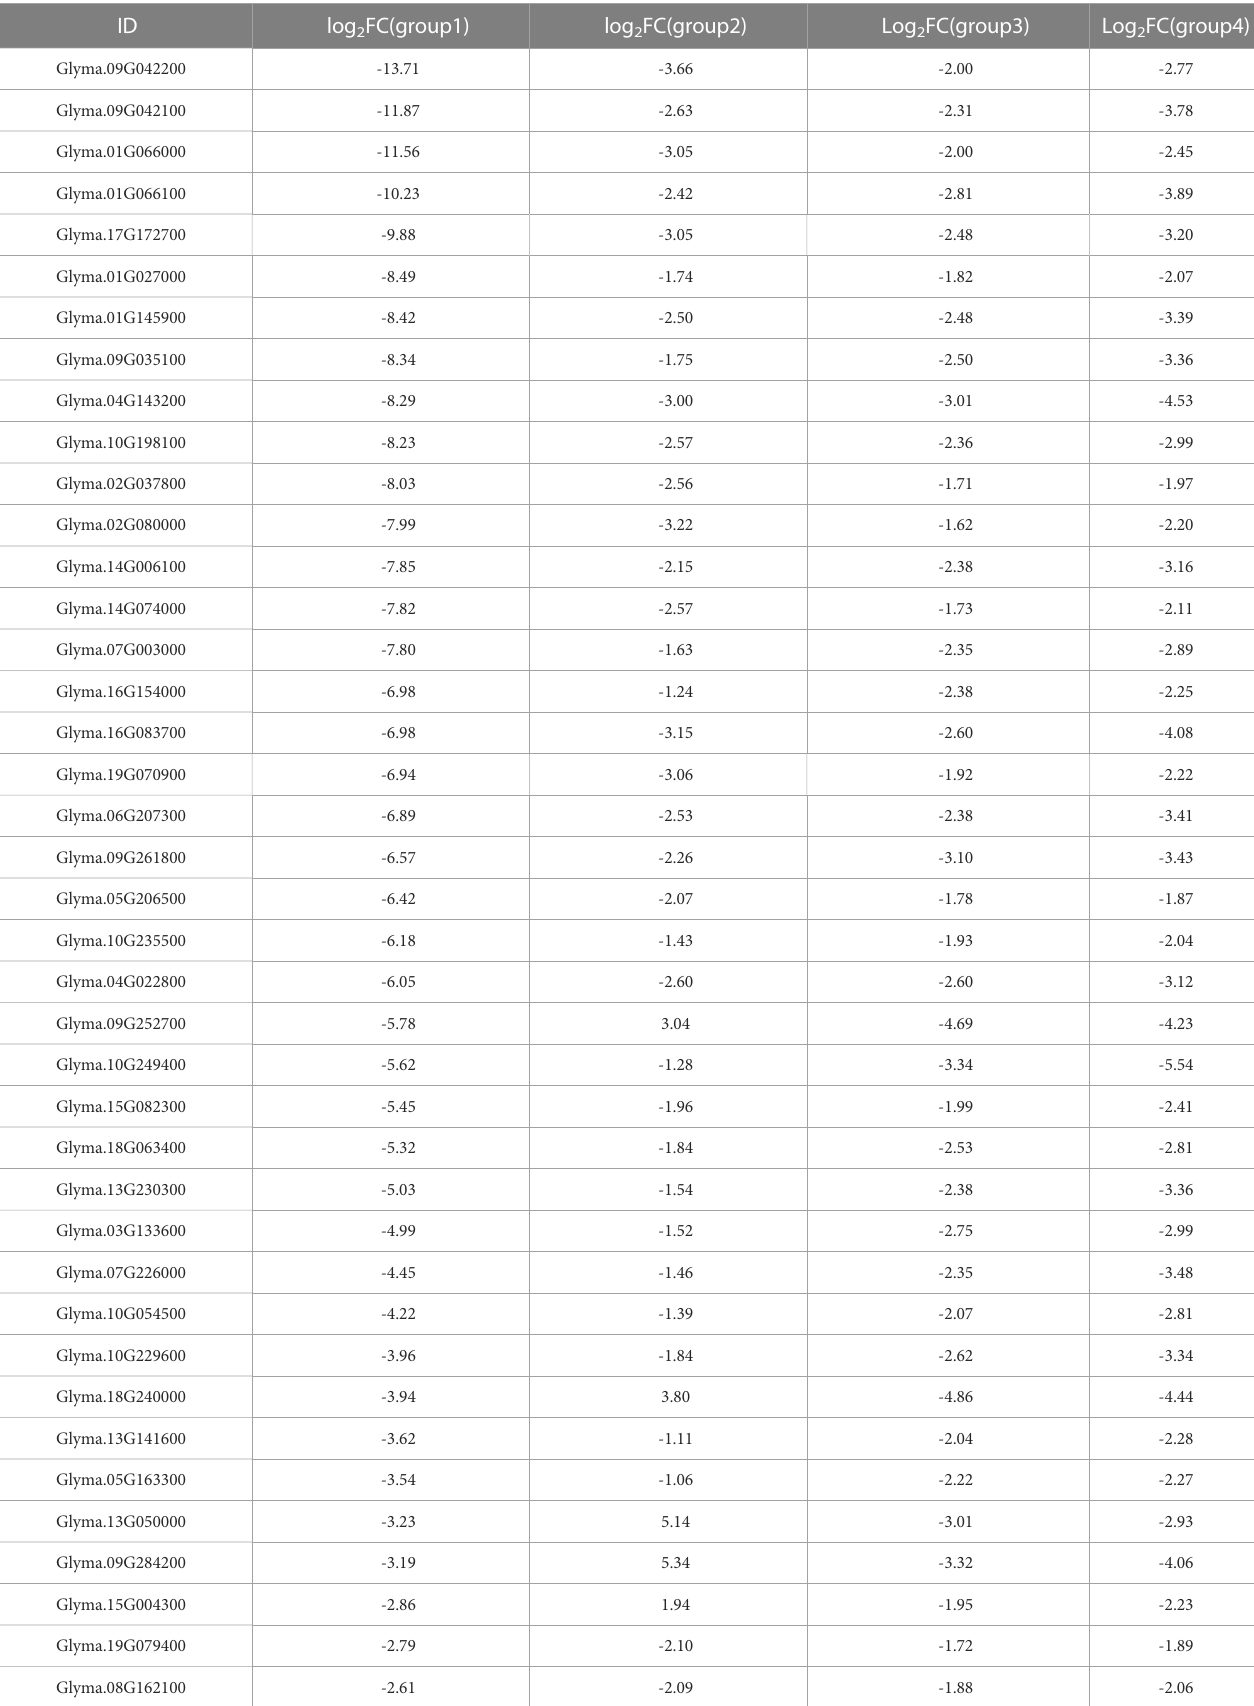
TABLE 1 The expression pro fi les of 53 common-DEGs and DEPs at both the UM and BP stages.